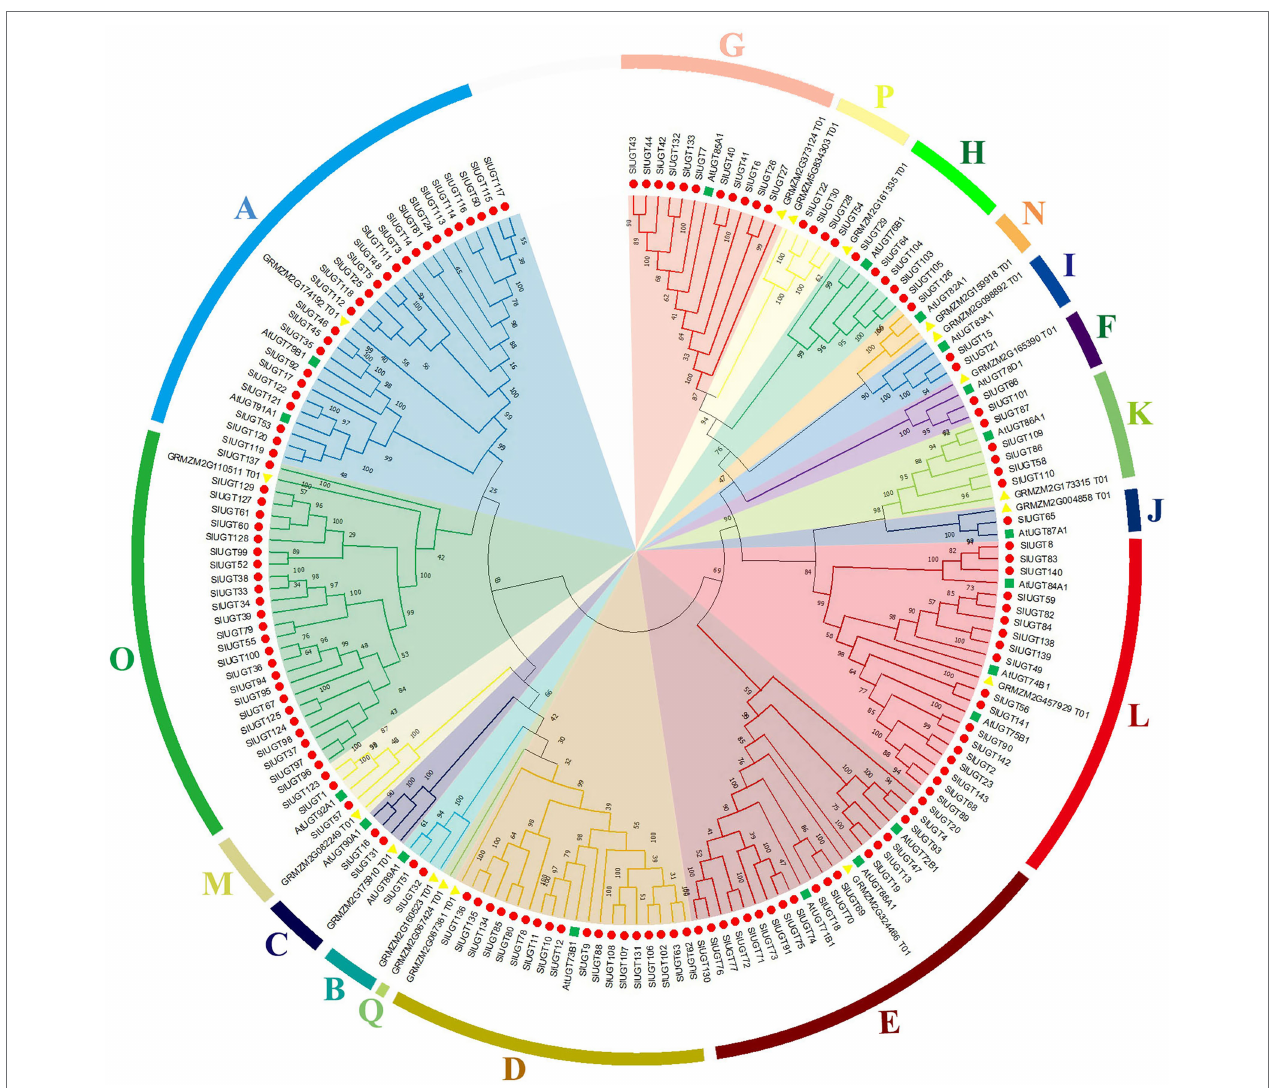
FIGURE 5 | Phylogenetic analysis of UGT family genes from tomato. The tree was constructed using the neighbor-joining method by aligning the amino acid sequences of tomato UGTs, Zea mays UGTs, and Arabidopsis